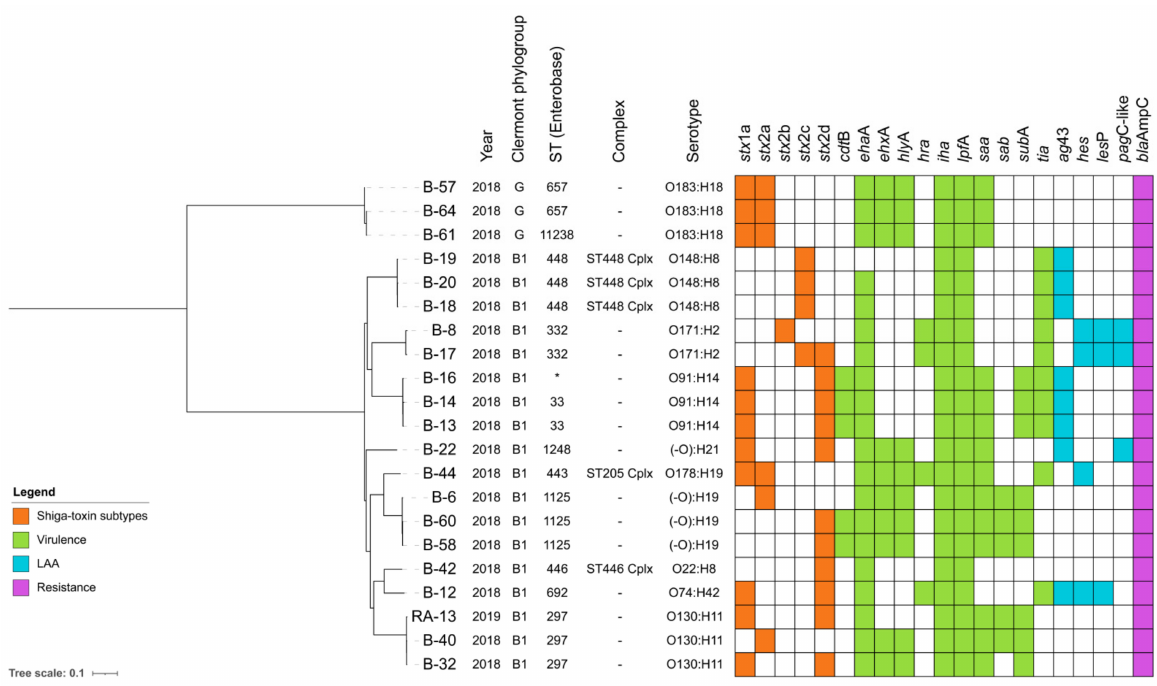
Figure 3. SNP-based phylogenetic tree of the 21 STEC strains isolated from cattle samples collected in Chile (this study). The heatmap was constructed based on Clermont phylogroup, multilocus sequence typing (MLST), serotype, and pres- ence/absence of Shiga-toxin subtypes and virulence, LAA-associated genes, and resistance genes. * Strain B-16 belongs to the novel ST-1661, a single locus variant (SLV) of ST33 at the fumC allele. ST11238 is an SLV of ST657 at the recA allele. SNP matrix is quoted in Table S3.